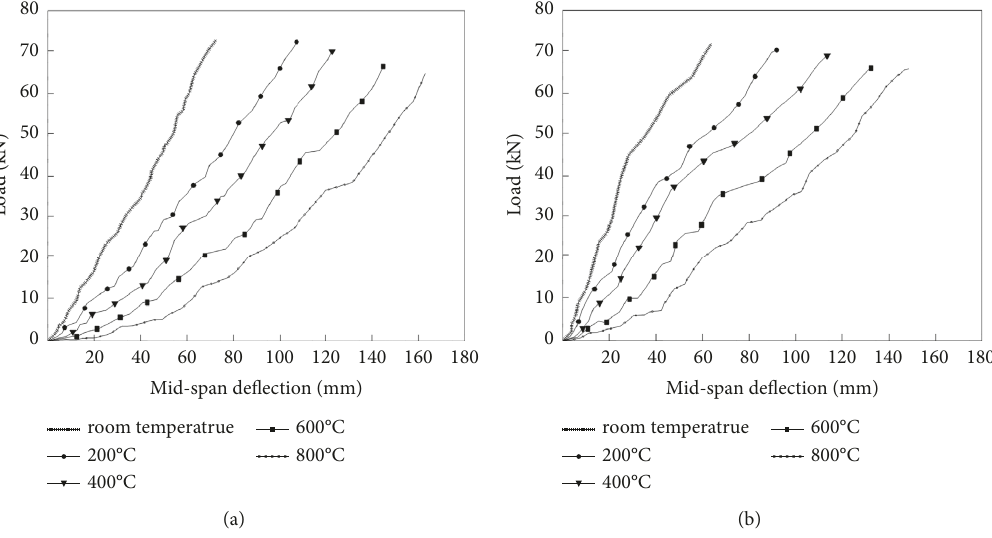
Figure 12: Mid-span reflection at different temperatures. (a) 150mm